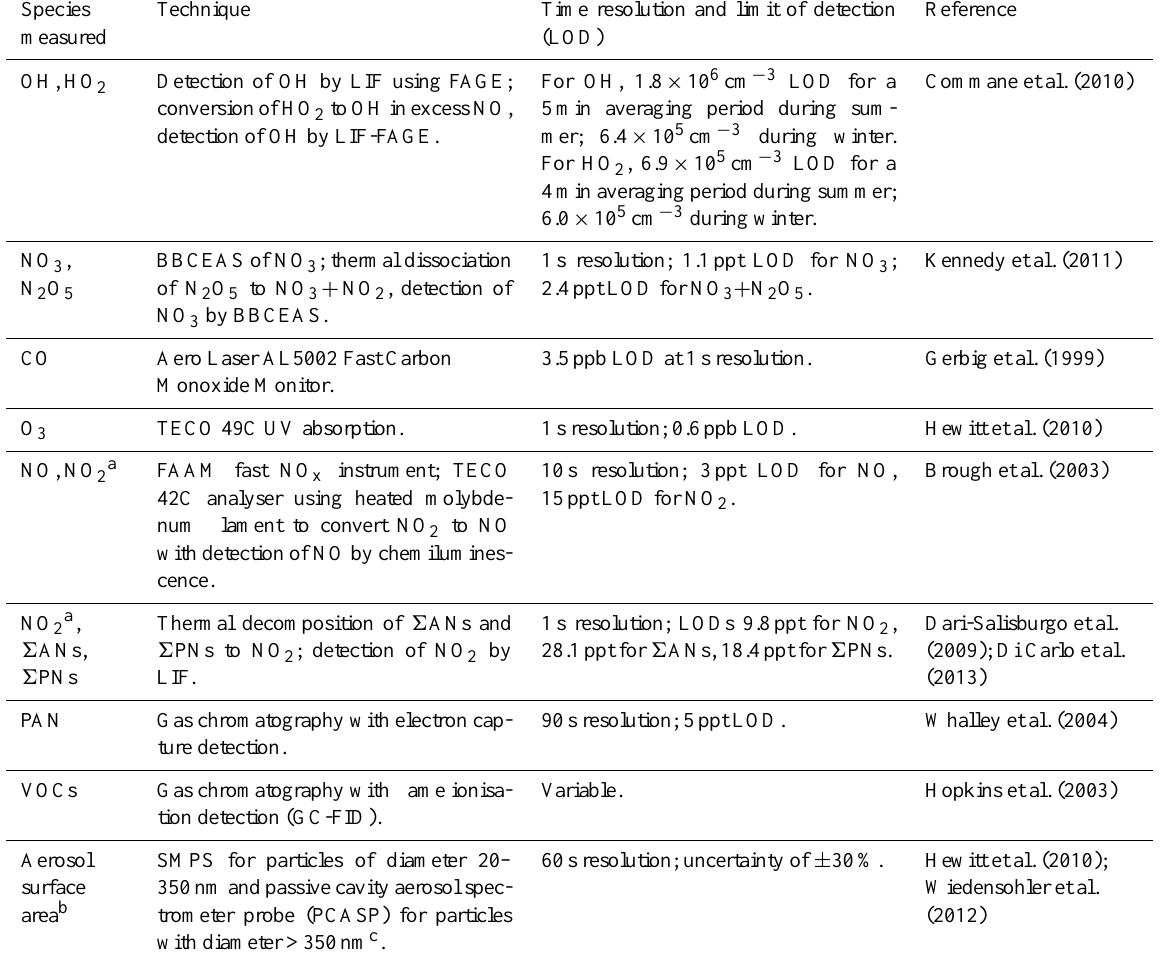
Table 1. Supporting measurements made onboard the BAe 146 aircraft during the RONOCO project and used in the model analysis presented here. a The NO 2 measurements used to constrain the model were made by the LIF instrument (Dari-Salisburgo et al., 2009; Di Carlo et al., 2013). 6 ANs – sum of alkyl nitrates; 6 PNs – sum of peroxy nitrates; PAN – peroxy acetyl nitrate; VOCs – volatile organic compounds. b Aerosol surface area is estimated for ambient relative humidity based on the measured dry size distribution and composition. c The total surface area SMPS + PCASP is within 10% of the total using the SMPS data alone. Note that the aerosol measurements do not show any evidence for enhanced coarse model aerosol at low altitudes, indicating the aircraft did not enter the marine boundary